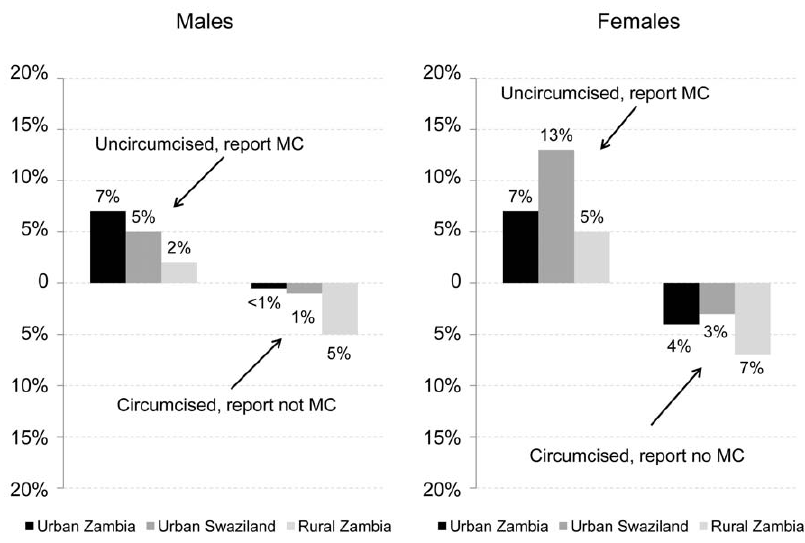
Figure 3. Direction of misreporting of MC status among those reporting.